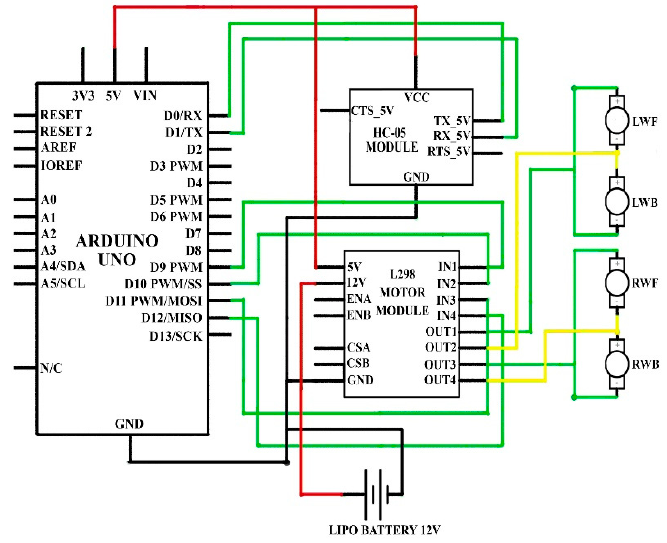
Figure 6. Circuit design of mobile-application system to control car.